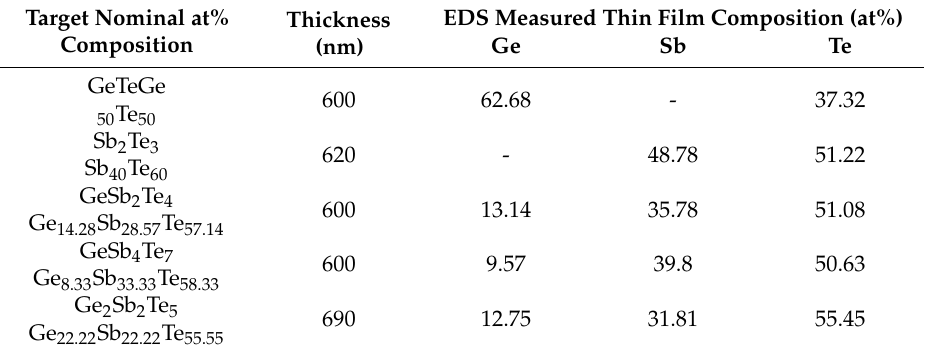
Table 1. The thickness (stylus profilometry) and elemental composition (EDS) of the thin films deposited using the 266-nm radiation with a 3.81 J / cm 2 fluence, a 60-min deposition time, and a 3-cm target–substrate distance. Target Nominal at% EDS Measured Thin Film Composition Thickness Composition (nm)